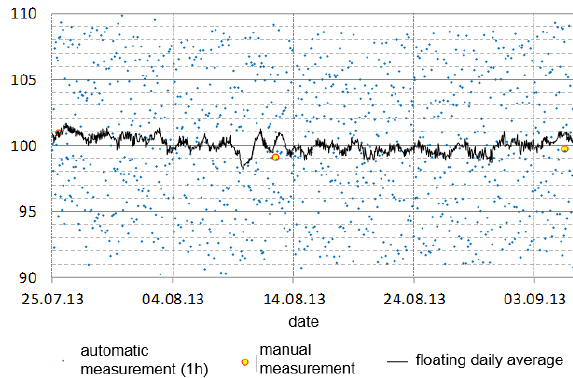
Fig. 12. V4 discharge variance (rel. to time period average %). Daily floating average embodies distinct fluctuation, caused by the atmospheric pressure compensation.